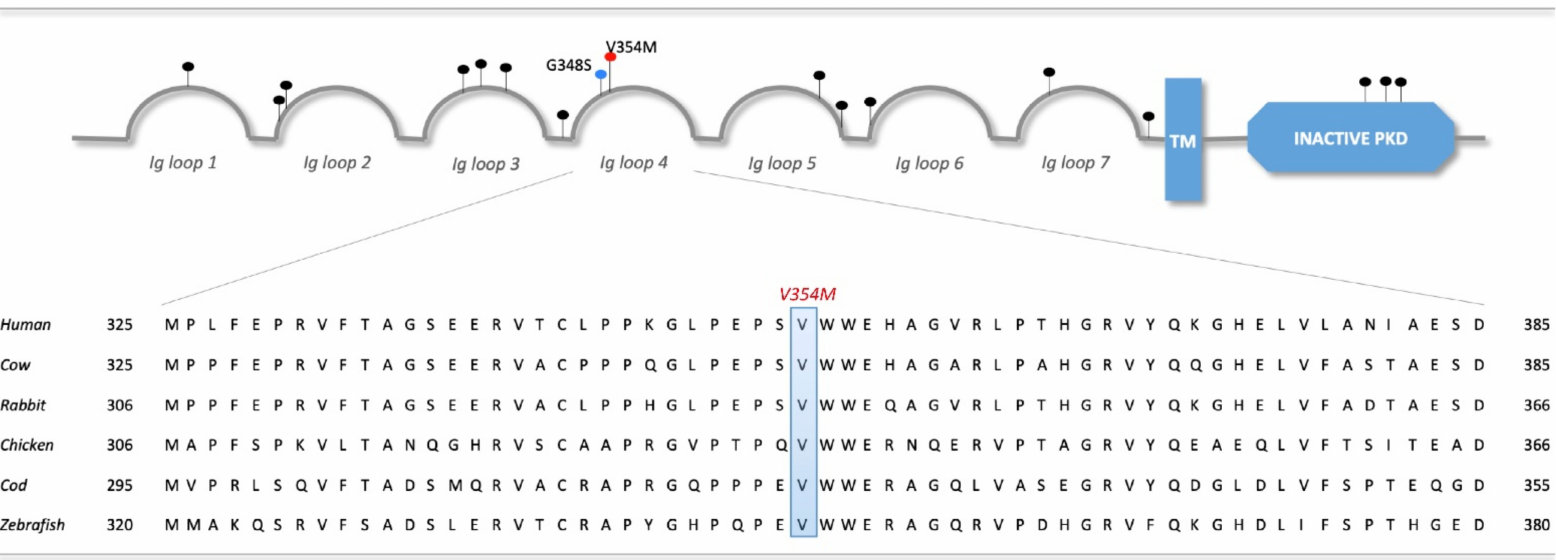
Figure 2. Localization of PTK7 mutations in CRC on protein level and mapping of the missense variant V354M to multiple sequence alignments of PTK7. All PTK7 somatic mutations identified in colorectal adenocarcinoma were extracted from cBioPortal (www.cbioportal.org) on the 15 March 2020 using TCGA PanCancer data and are marked by black pins. Germline variants are represented by colored pins, blue for the G348S variant in neural tube defects and red for the V354M variant identified in this study. The induced amino acid substitution V354M affects the Immunoglobulin (Ig) loop 4 domain (pp. 309–407) and is mapped to multiple protein sequence alignments of PTK7 for selected species. PTK7 sequences were downloaded from Ensembl (GRCh37/hg19) [24] for human (ENSG00000112655), cow (ENSBTAG00000012761), rabbit (ENSOCUG00000002874), chicken (ENSGALG00000008609), cod (ENSGMOG00000011589), and zebrafish (ENSDARG00000011863). As demonstrated, the variant affects an amino acid residue identically in all sequences and thus is highly conserved. TM — transmembrane domain , PKD — protein kinase domain